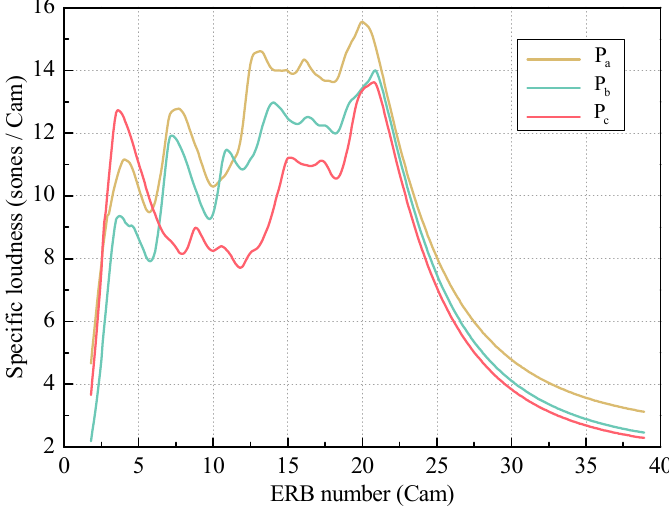
Figure 11. Specific loudness of three sound field points.